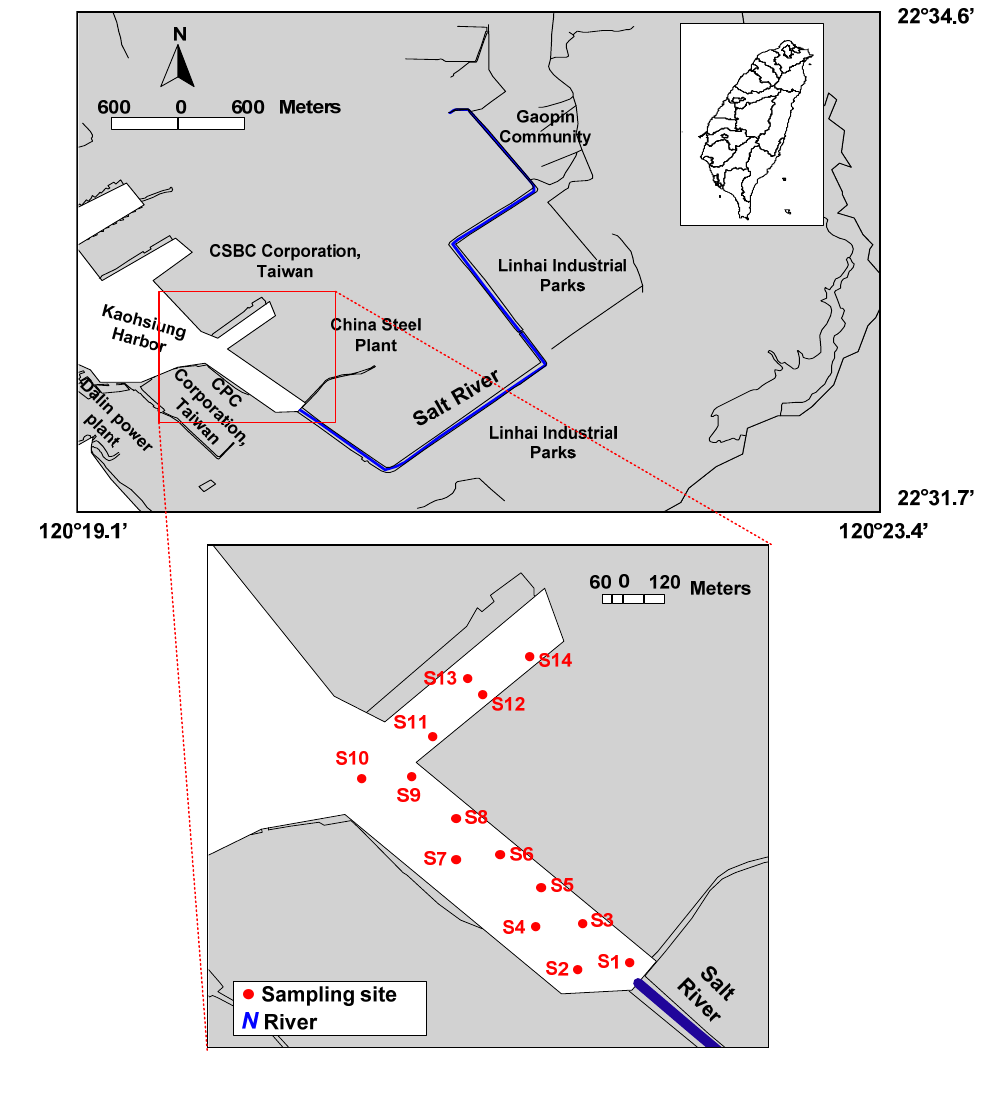
Figure 1. Map of the study area and sampling